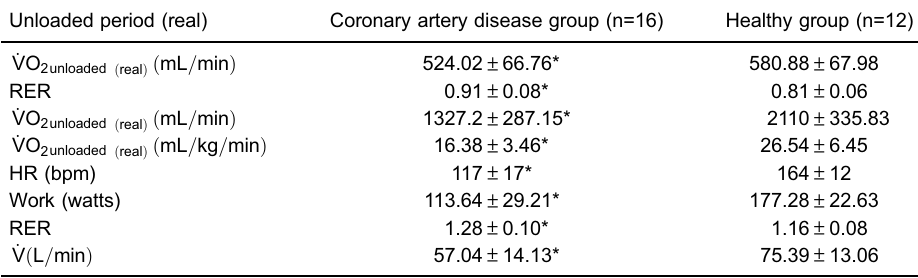
: Data are reported as mean ± SD. V O 2 : oxygen uptake; RER: respiratory exchange ratio; HR: heart rate; : bpm: beats per minute; V : ventilation. *P o 0.005, compared to the healthy group (nonparametric Mann- Whitney